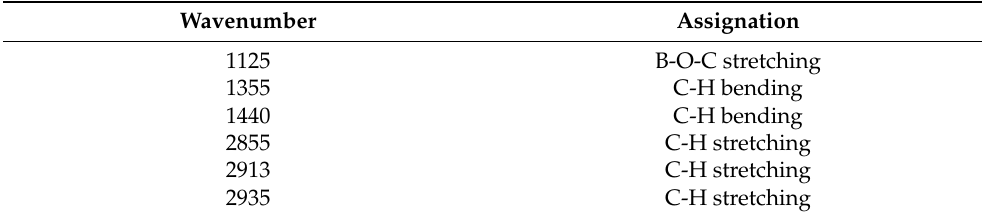
Table 1. Tentative assignations of observed Raman peaks for PVA-borax